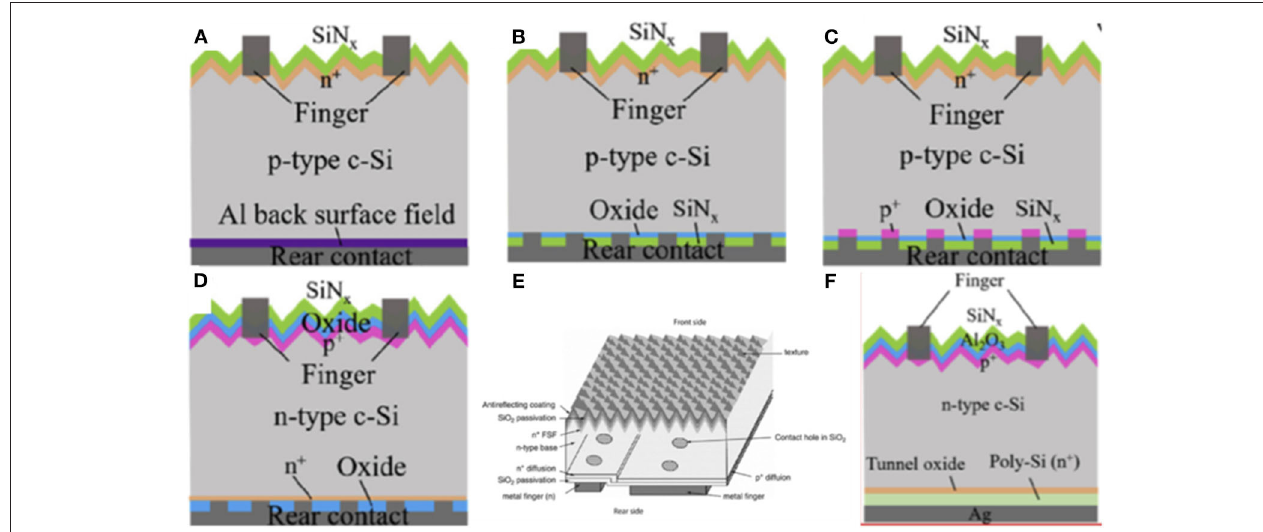
FIGURE 10 | Schematic view of (A) the standard full-area Al-BSF cell, (B) the PERC device, (C) the PERL cell, and (D) the PERT cell (reproduced from ref. 77, copyright 2019, Elsevier). (E) IBC (reproduced from ref. 17, copyright 2015, Wiley VCH). (F) TOPCon.